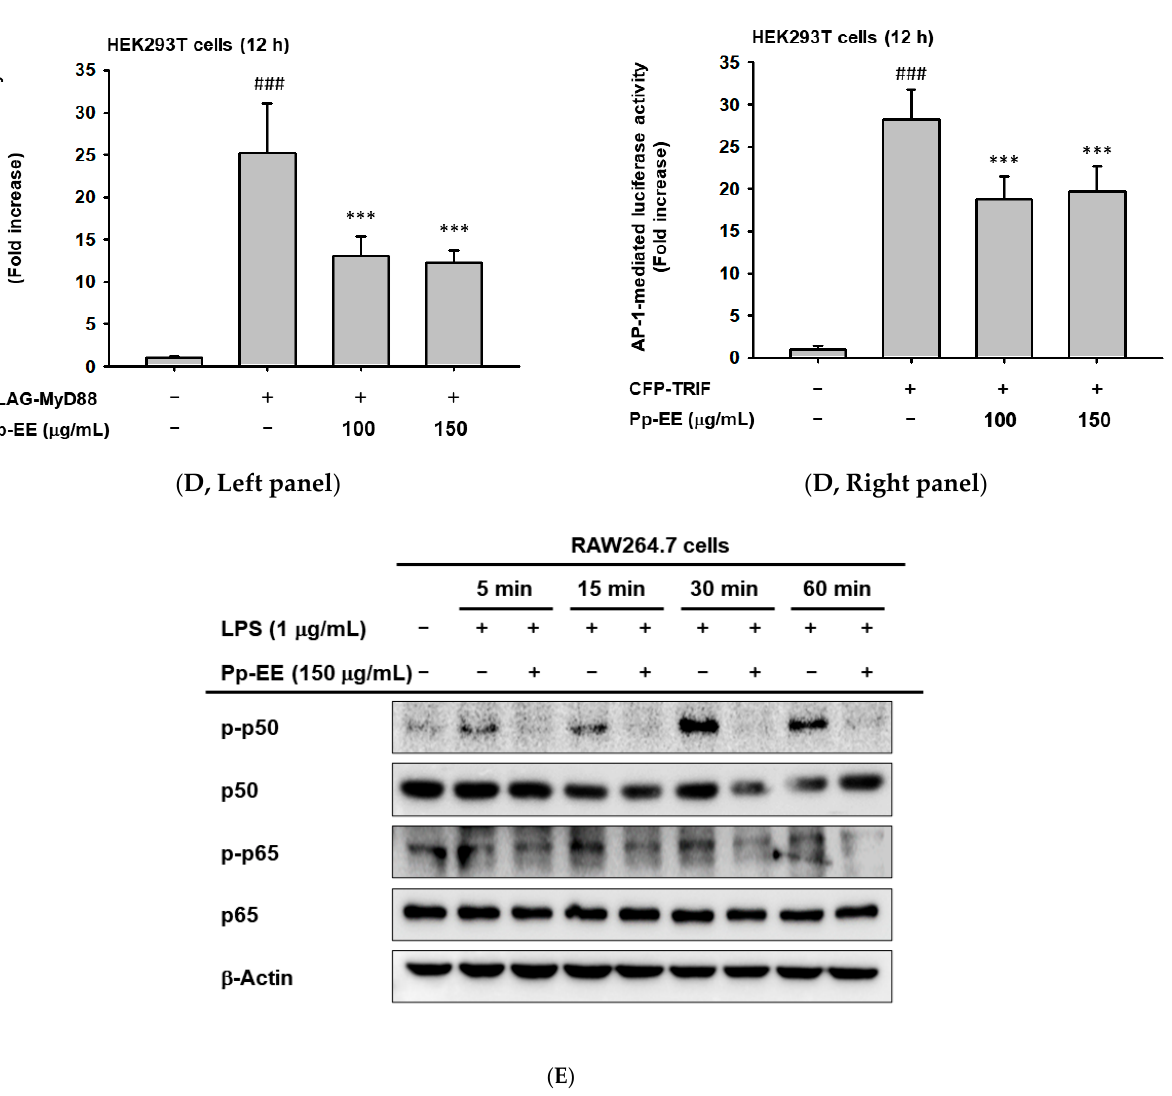
Figure 2. Pp-EE exerts influence on decreasing expressions of mRNA and transcription factor. ( A ) Changes in mRNA expression level in RAW264.7 cells induced stimulation through LPS after pretreatment of Pp-EE (0–150 µ g/mL). ( B ) Cytotoxicity of Pp-EE for HEK293T cells with indicated concentrations of Pp-EE for 12 h. ( C , D ) The effect of Pp-EE (0–150 µ g/mL) on the activation of transcription factor (NF- κ B or AP-1). HEK293T cells were co-transfected with an NF- κ B or AP-1 luciferase construct and β -gal plasmid for control with or without MyD88 (left panel) or TRIF (right panel). ( E ) The total and phosphorylated levels of p50, p65, and β -actin analyzed by immunoblotting assay. LPS (1 µ g/mL)-stimulated RAW264.7 cells with or without Pg-EE (150 µ g/mL) were prepared. ###: p < 0.001 compared to the normal group, *: p < 0.05, **: p < 0.01, and ***: p < 0.001 compared to the control group. − : no treatment and +: treatment.